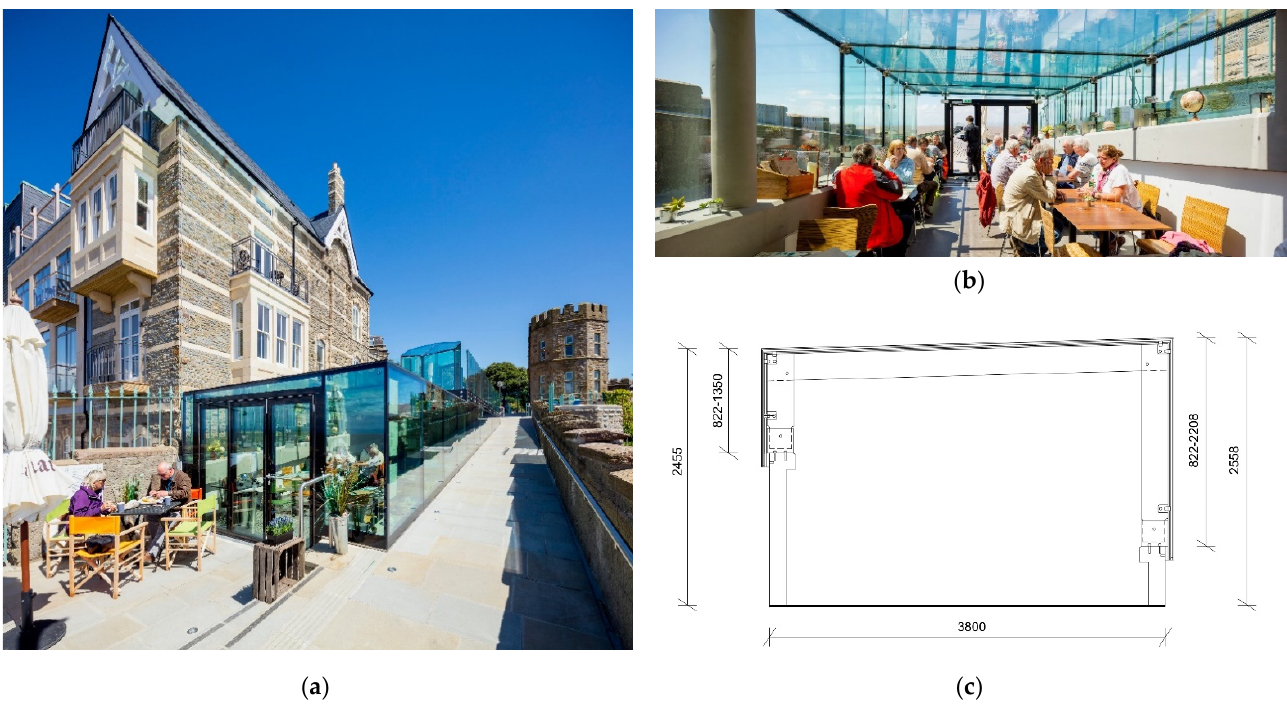
Figure 21. The Clevedon Pier Visitor Center: ( a ) view of the tearoom pavilion (© Fotohaus); ( b ) view inside the pavilion (© Fotohaus); and ( c ) glass frame geometry (figure by the author).